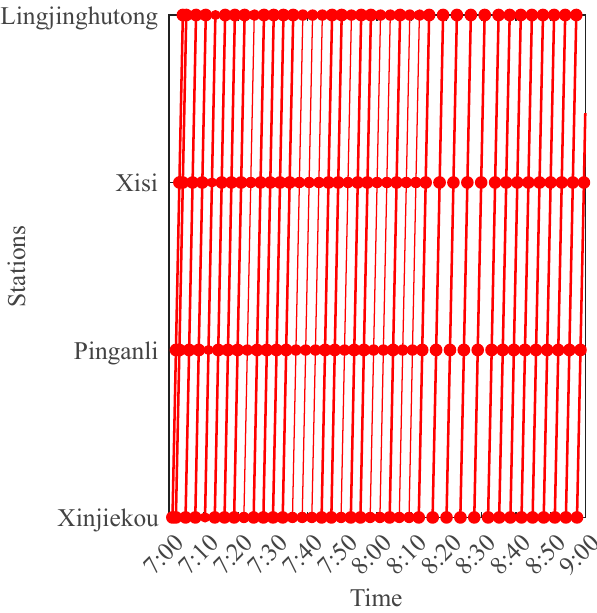
Figure 22. Multi-train operating time optimization diagram.